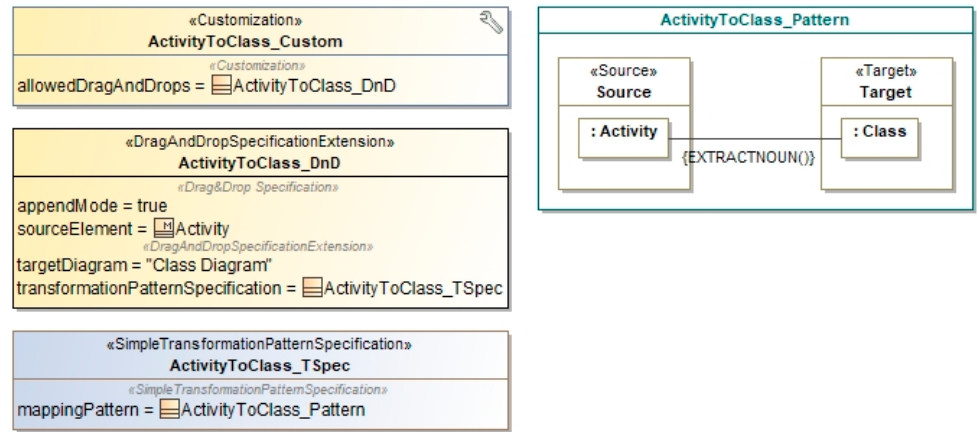
Figure 7. M2M transformation specification for UML Activity to UML Class transformation.